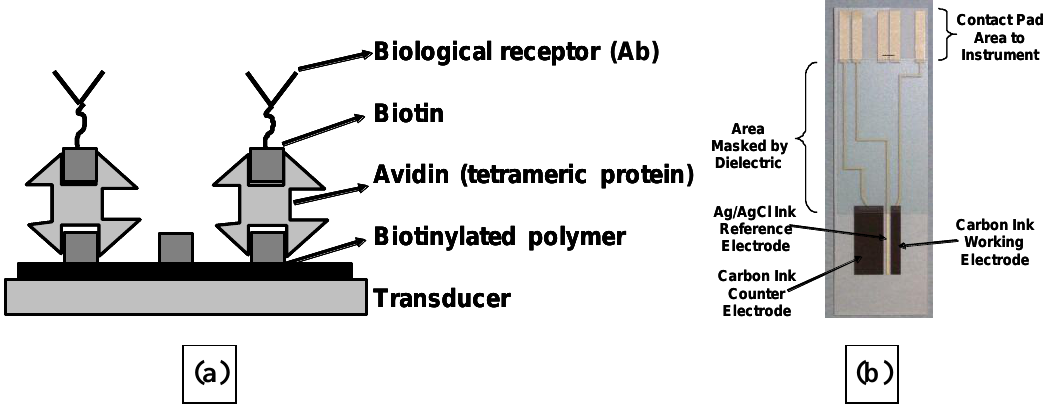
Figure 21. (a) Schematic of the immobilisation of antibodies on screen-printed electrodes (b) screen printed electrodes used within this